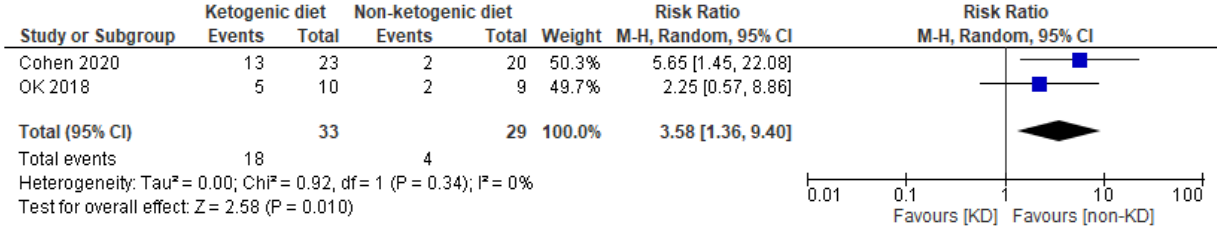
Figure 4. Forest plot of risk ratio in random effects model for ketosis in comparison of KD and non-KD group.